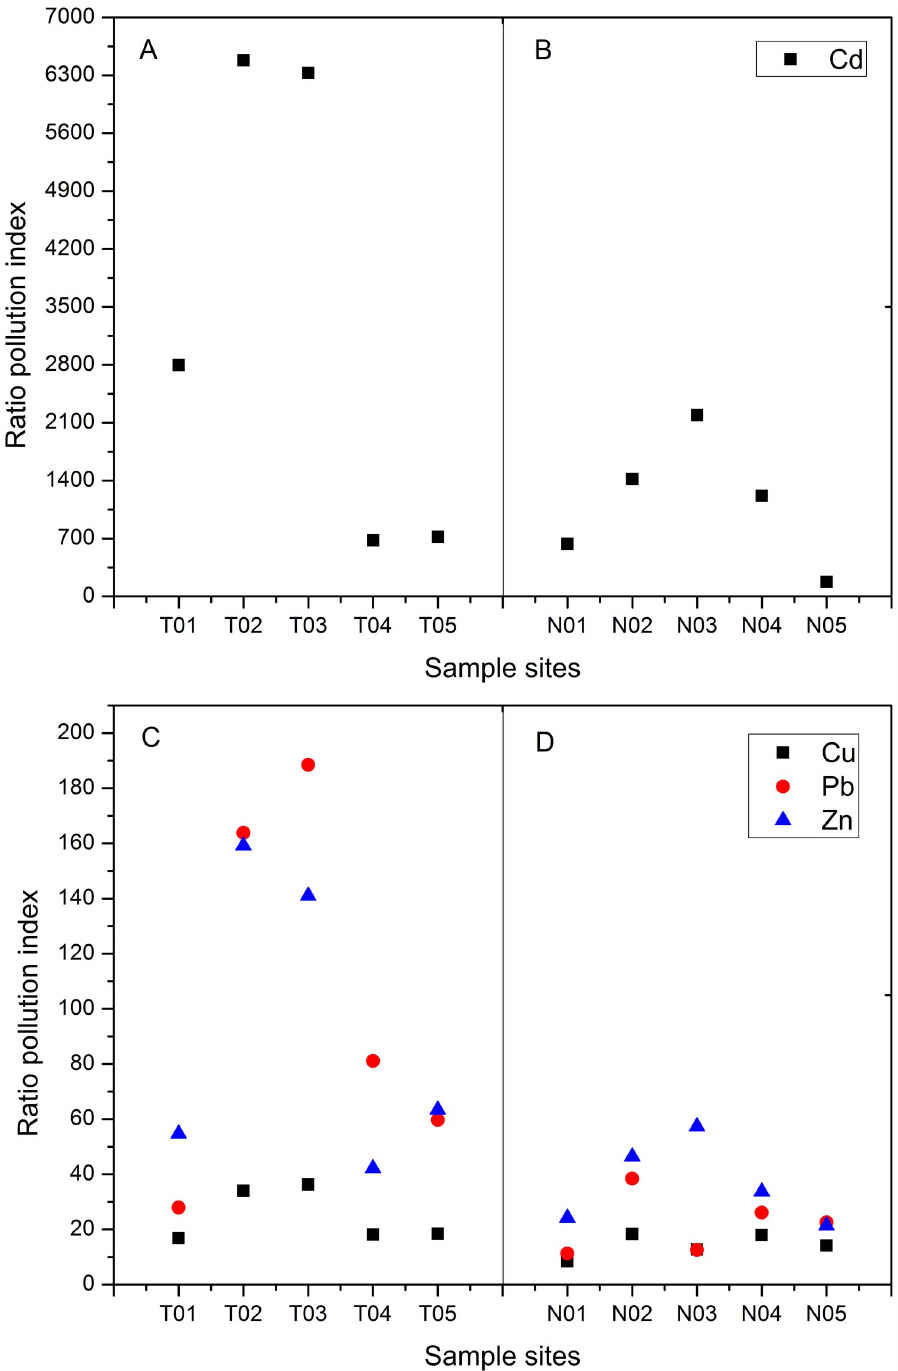
Figure 2. Ratio pollution index of Cd, Cu, Pb and Zn in sediment and soil samples from Xiawangang River.